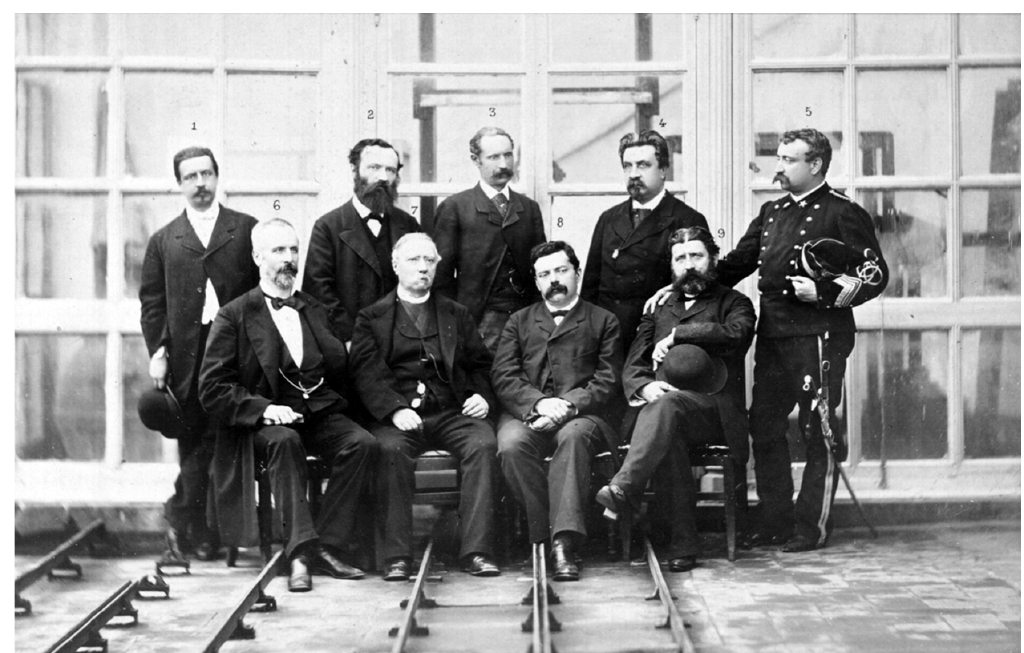
Fig. 3. Italian Commission to measure the European degree. 15 June 1880. Standing (left to right): Nobile, Lorenzoni, Obelholtzer, General Mayo, the President, Colonel Ferrero. Seated (left to right): Betocchi, General Ricci, Schiaparelli, Respighi (photograph, Astronomical Observatory of Padua, historical